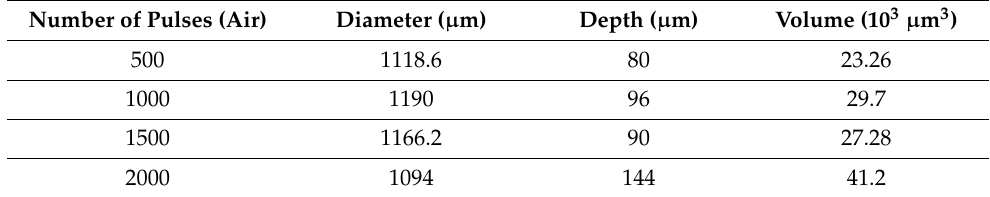
Table 1. The variation in ablated diameter, depth and volume of laser ablated Cd for 500, 1000, 1500 and 2000 laser pulses, at constant fluence of 3.6 J cm − 2 in